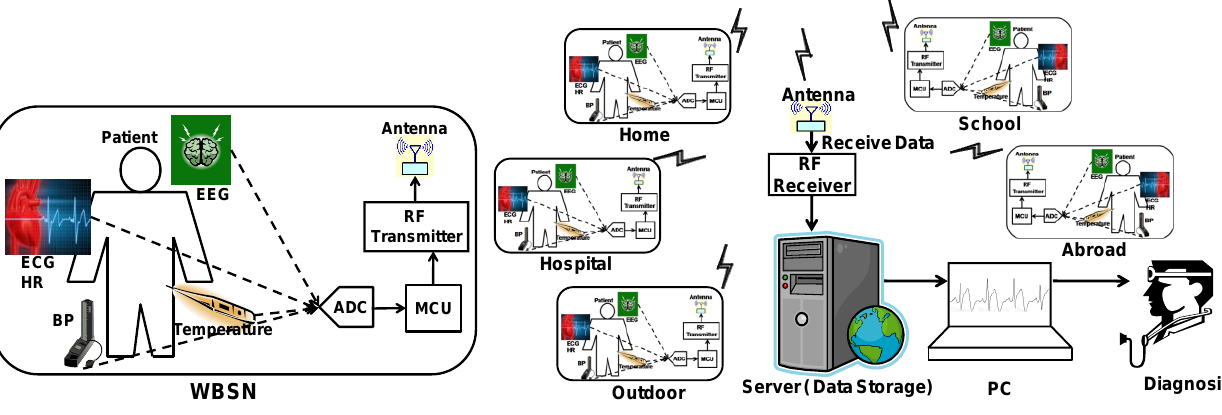
Figure 1. WBSN system scheme for hospital using or health watching